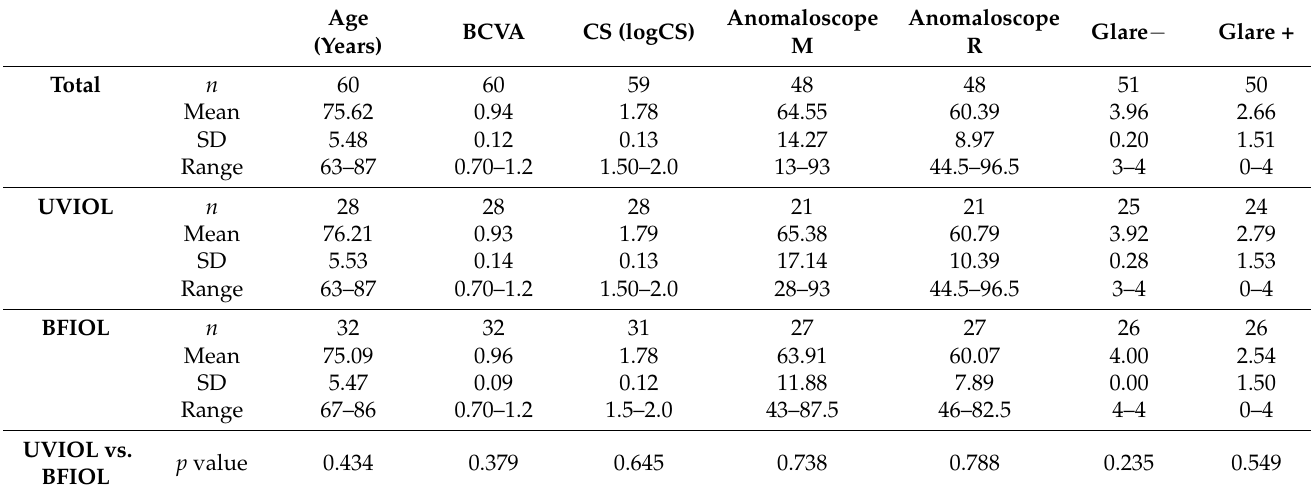
Table 1. Descriptive statistics of the analyzed parameters with the p